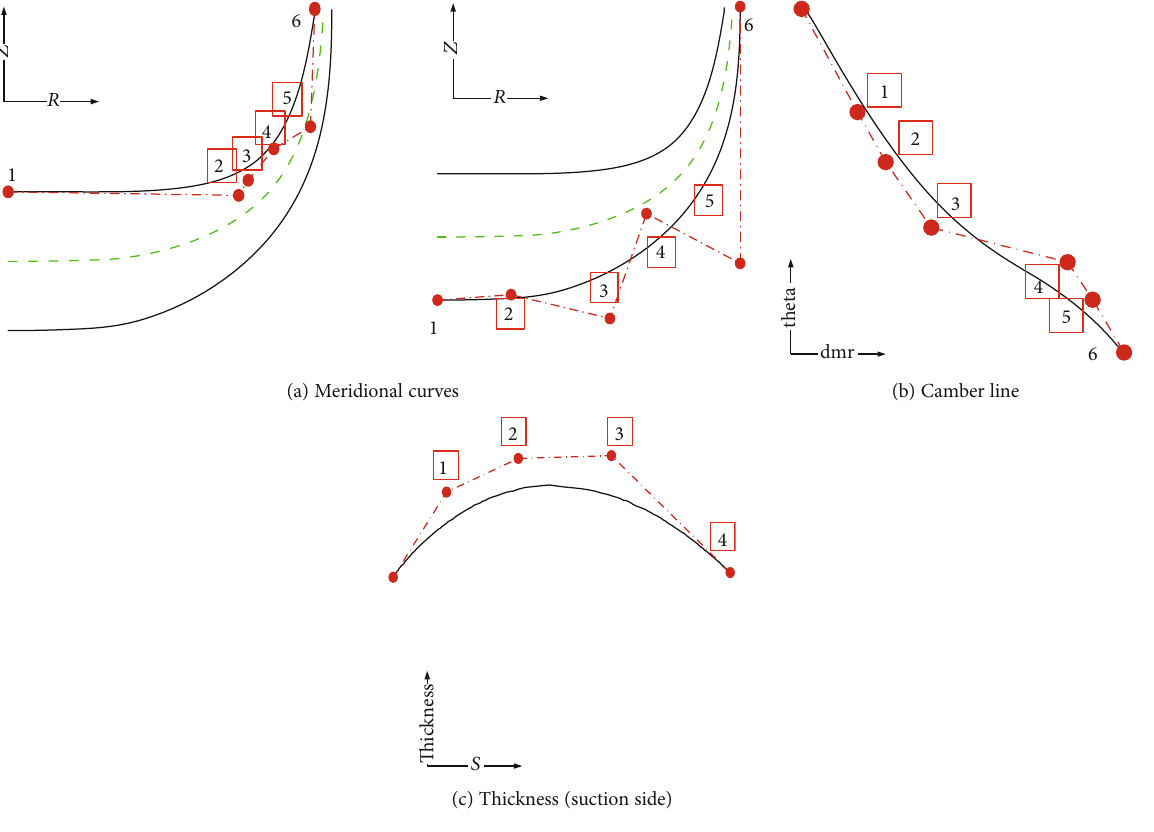
Figure 6: Pro fi le parameterization. Table 1: The variables of the parameterization model.